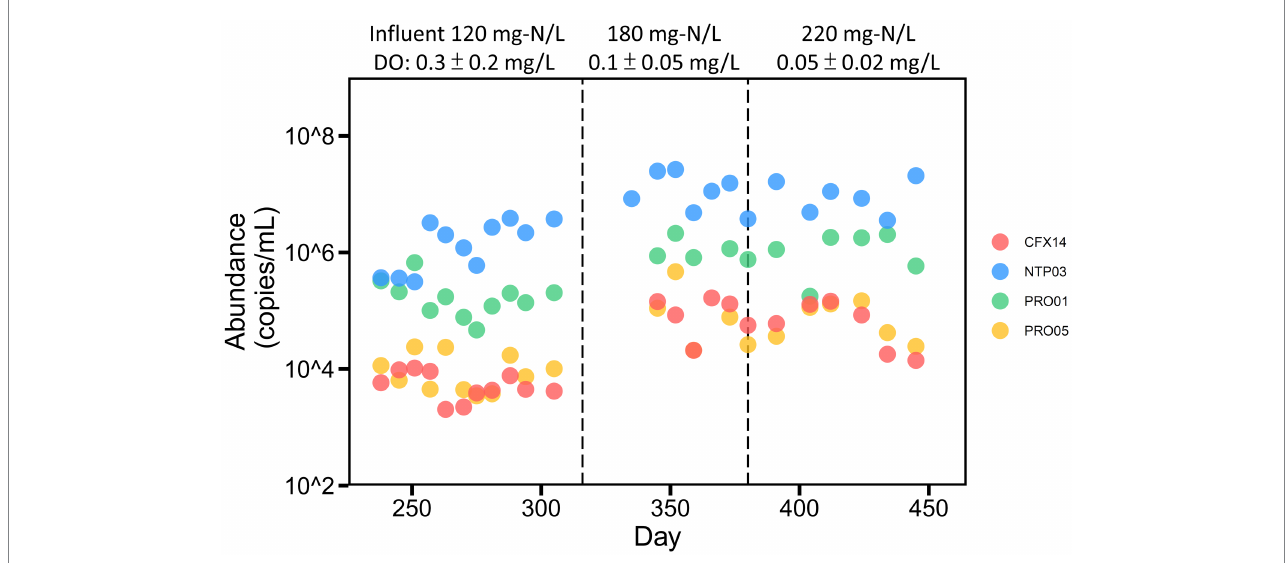
FIGURE 5 Temporal dynamics of potential ammonia-oxidizing members in the reactor. The reactor was fed with stepwise increased ammonium and operated under a constant retention time of 6.25 days. Flowrate of air supply was maintained at 9.7 ml/min on average. Aeration time stepwise decreased from 720 min/day (day 237–257), 480 (day 258–261), 120 (day 262–269) to 80 (since day